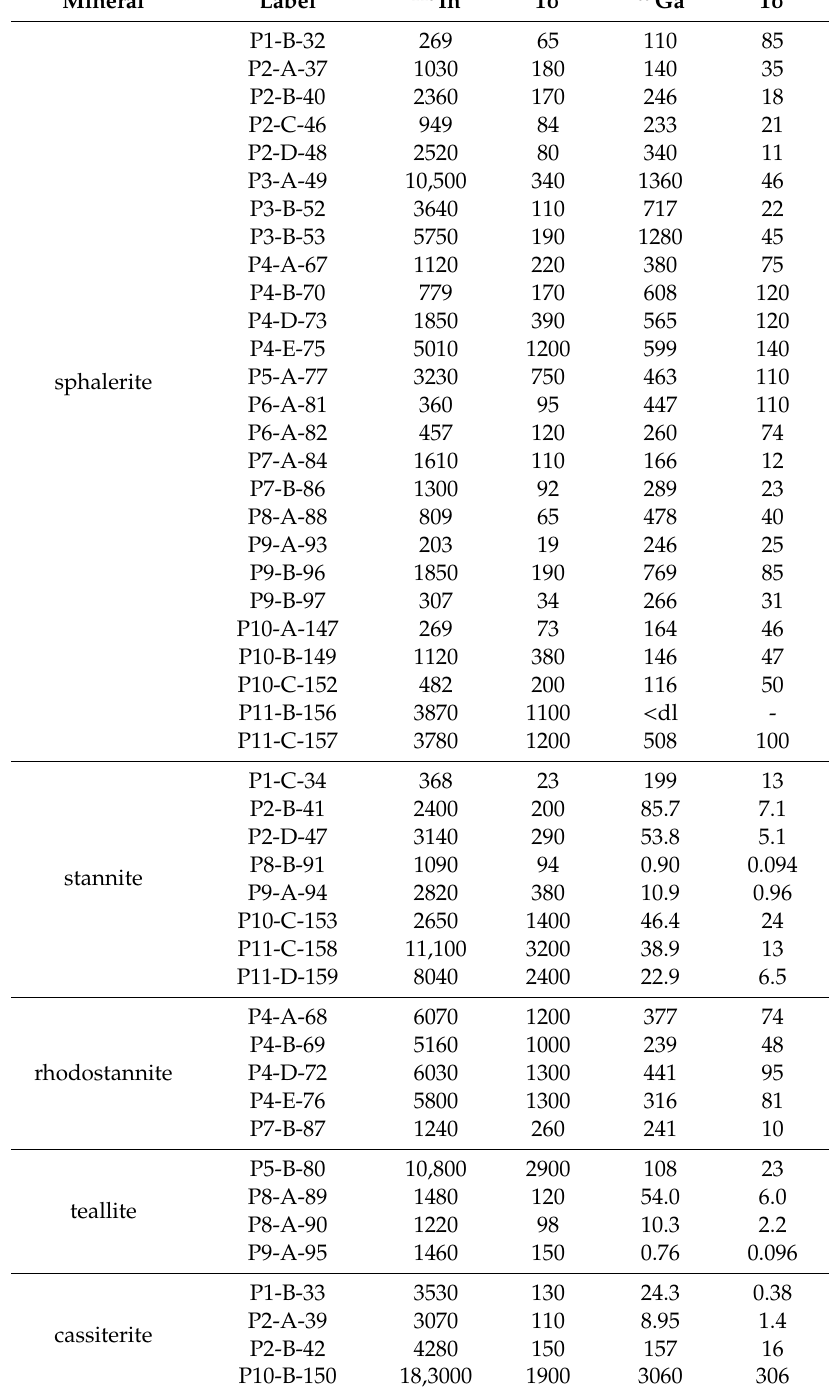
Table 1. In and Ga determinations by means of LA-ICP-MS in selected minerals of the Poop ó deposit. All values are reported in ppm. Data selected from Table